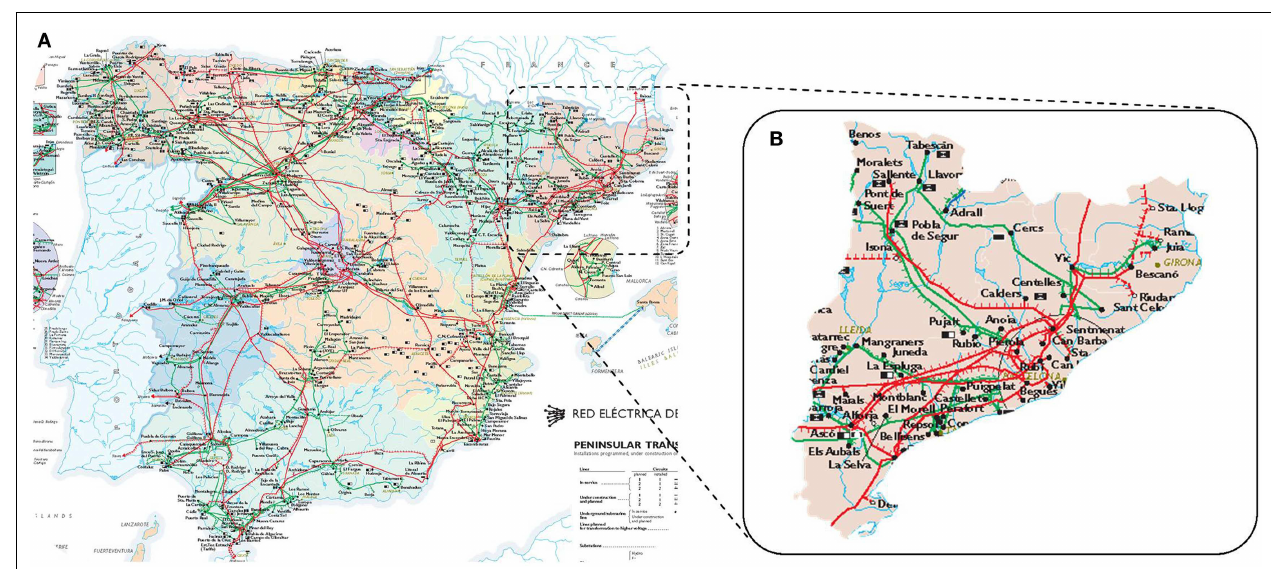
FIGURE 5 | Power transmission networks . (A) National Spanish network. (B) Catalan subsystem. Red and green colors show 400 and 220kV electric lines, respectively (source: